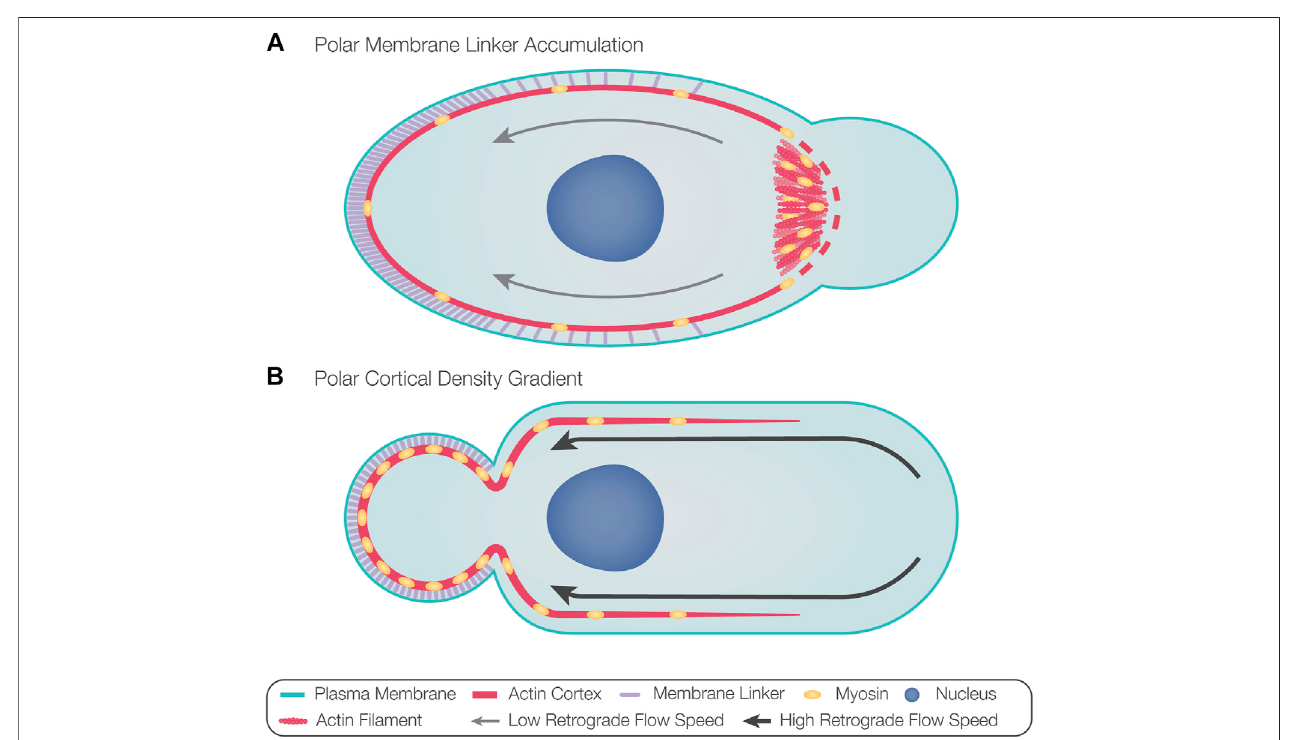
FIGURE 3 | Models for directing bleb formation to the front of migrating cells. (A) Actin polymerization at the future leading edge provides a platform for the recruitment of myosin motors. Actomyosin polymerization and contraction result in actin retrograde fl ow, advecting membrane linker molecules toward the opposite aspect of the cell, thus de fi ning the rear. Accumulation of membrane linker molecules at the rear prevents blebbing at this aspect of the cell. Increased actomyosin contractility at the front could introduce cortical breaks, which, in addition to the reduced levels of membrane linkers, could favor the formation of blebs at the leadingedge. The polarized contractile activity could also result inlocal pressure elevation, favoring bleb formation if thehydrostaticpressure does notrapidly equilibrate throughout the cytosol. (B) Local fl uctuations incontractility can cause the fl ow ofactin and myosin toward thecontractile region, thus dictating the position ofthe future rear. High retrograde fl ow speeds of polymerized actin from the front maintain polarization by establishing a cortical density gradient in the direction of the rear, thus favoring positioning of the bleb at the opposing side. Likewise, membrane linkers accumulate at the rear, potentially further inhibiting bleb formation at this aspect of the